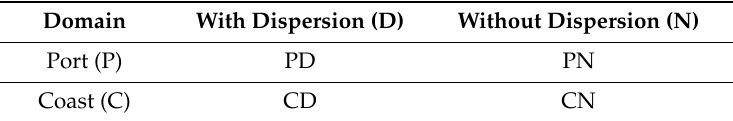
Table 1. Numerical experiment classes.